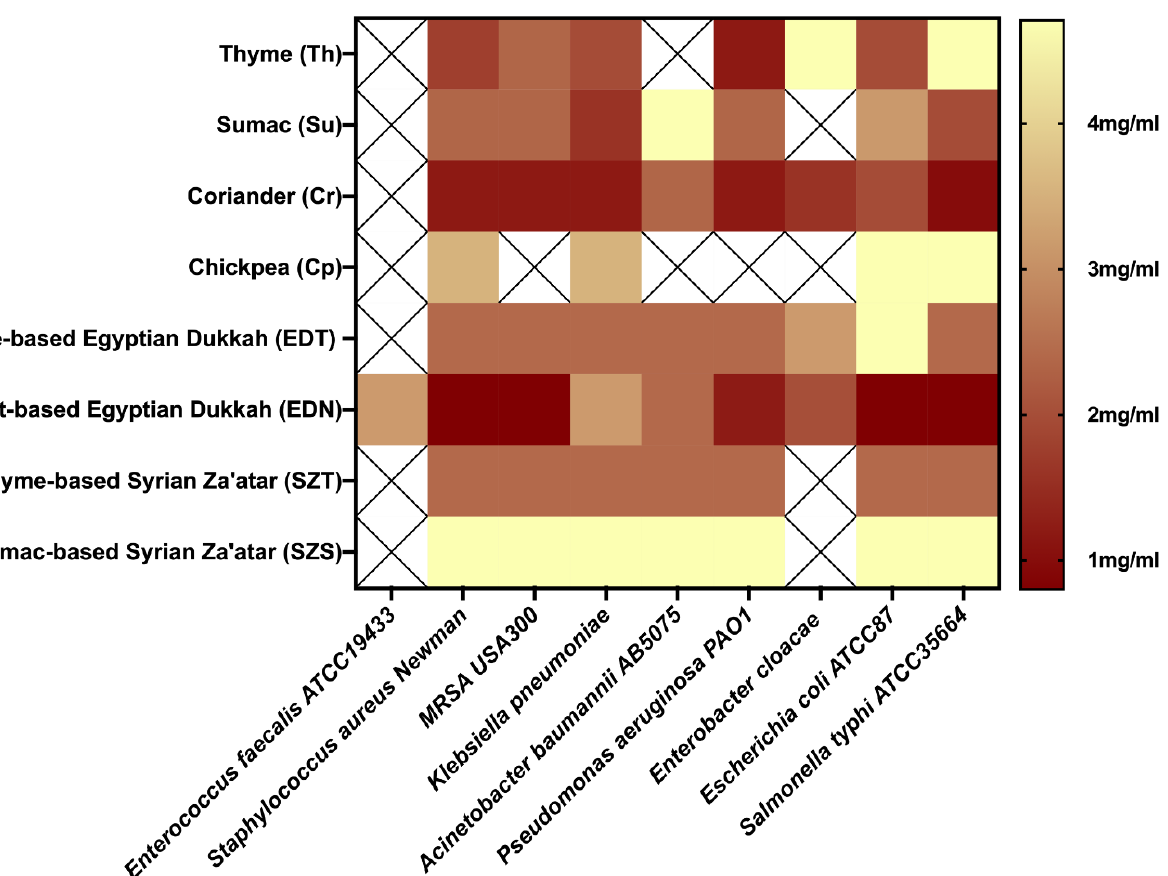
Figure 1. Heatmap showing the vapor-phase antibacterial activity of the tested herbal mixtures and their major individuals. The antibacterial activity is represented by means of vapor-phase minimum inhibitory concentration (VP-MIC). Dark red and yellow represent the lowest and highest VP-MIC (mg/mL), respectively. Symbol “X” means that there was no antibacterial activity detected within the tested concentrations.